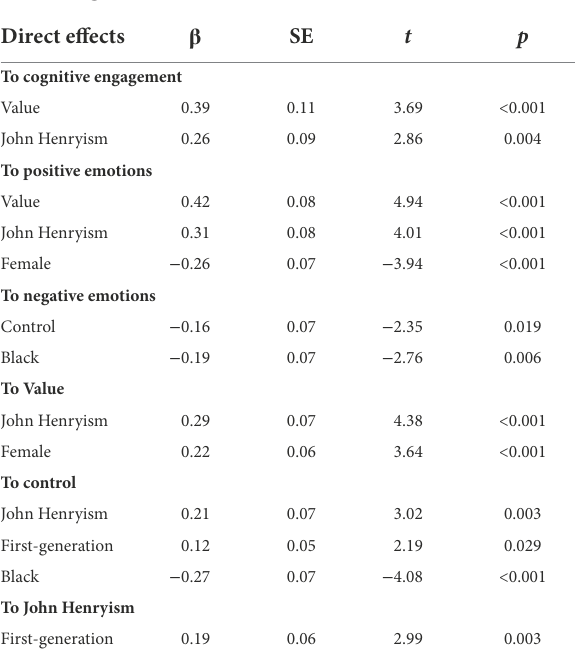
TABLE 5 Significant direct effects.